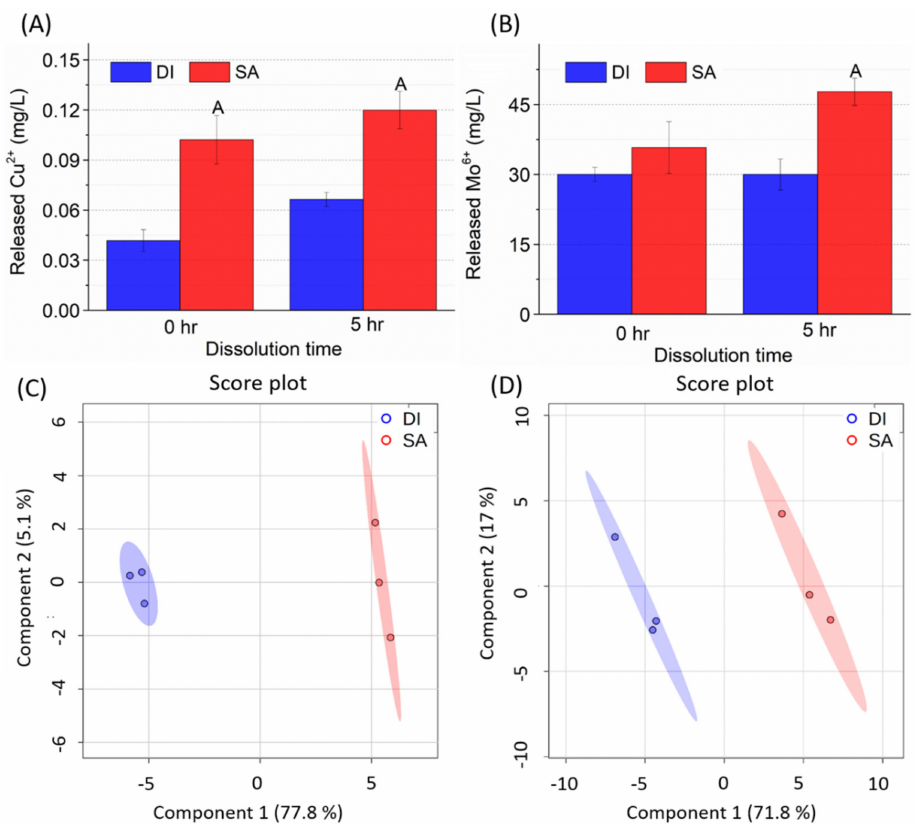
Figure 1. Metal ions released from ( A ) 100 mg/L Cu(OH) 2 NMs and ( B ) 100 mg/L MoO 3 NMs in DI water (DI) and surfactant containing suspensions (SA). PLS-DA score plots of overall metabolites in wheat ( C ) leaves and ( D ) roots after one-week foliar exposure to DI and SA solutions. Three replicates were used under each